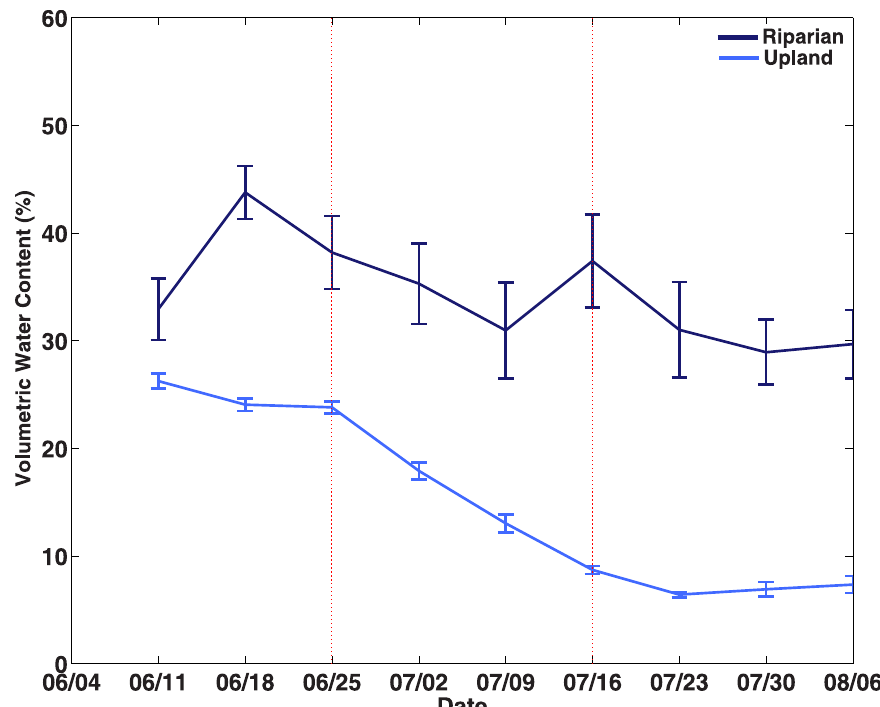
Fig 1. Seasonal soil moisture. Weekly averaged soil moisture in upland and riparian soil plots during the 2013 growing season.